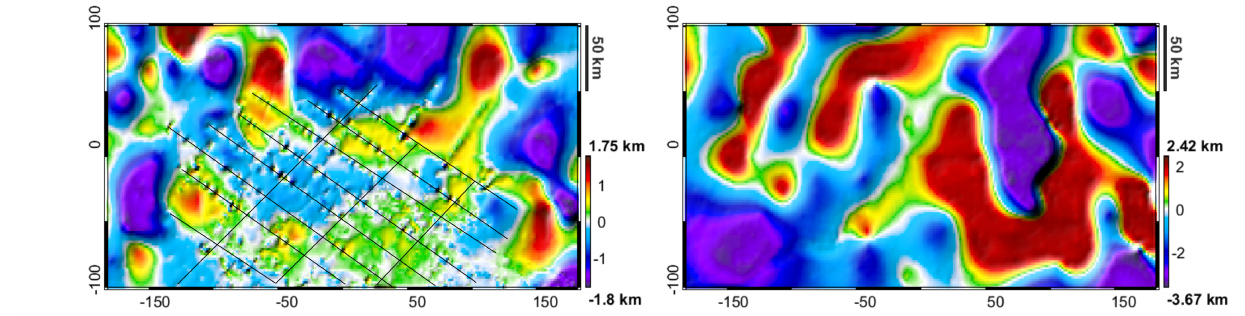
Figure 9. Differences between true and a priori model of Scenario 2 inversion for the base of the Messinian layer ( left ) and for the Moho ( right ). Black lines represent the simulated seismic